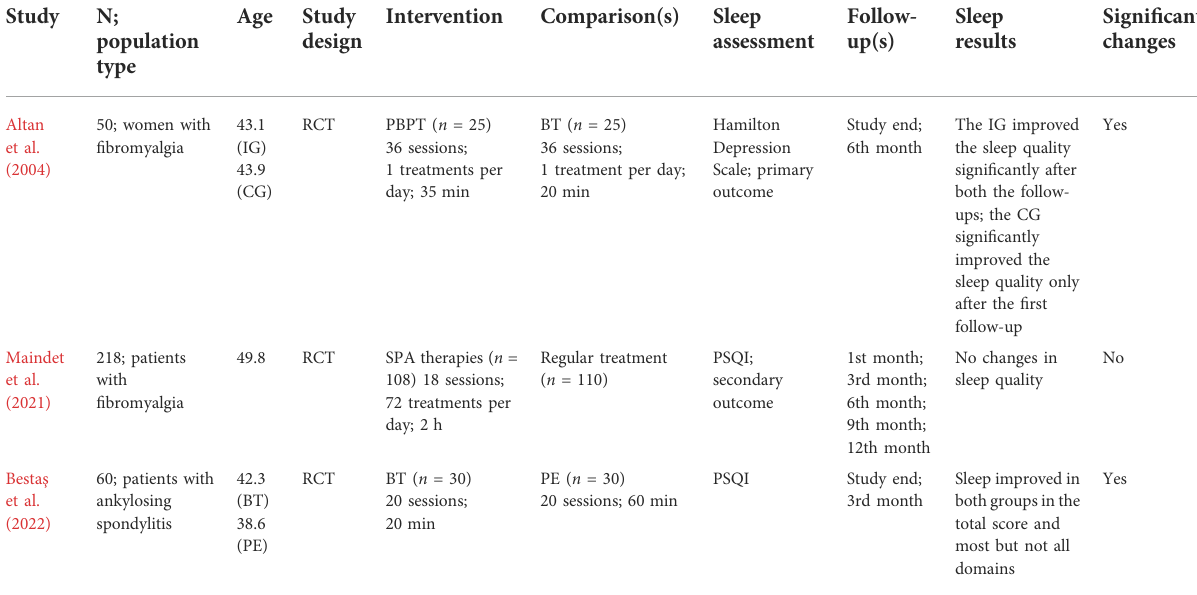
TABLE 4 Balneotherapy and physical exercise – Balneotherapy and in-pool physical exercise.